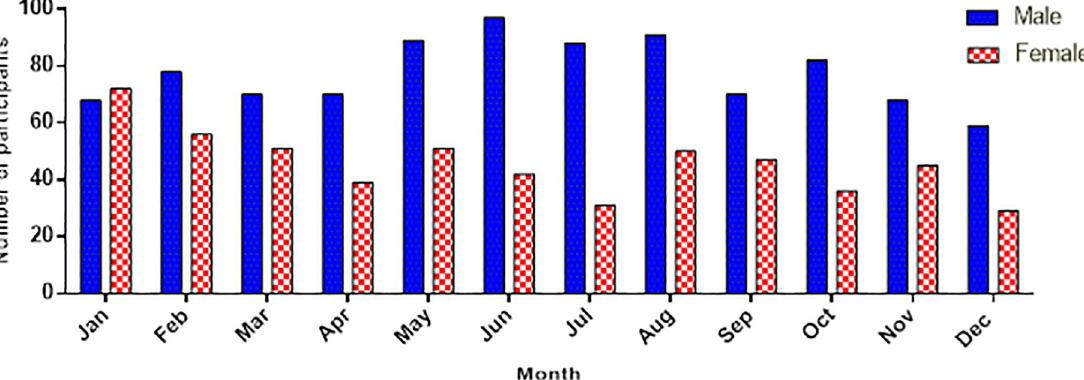
Fig 1. Bar graph of number of participants by month of the year and